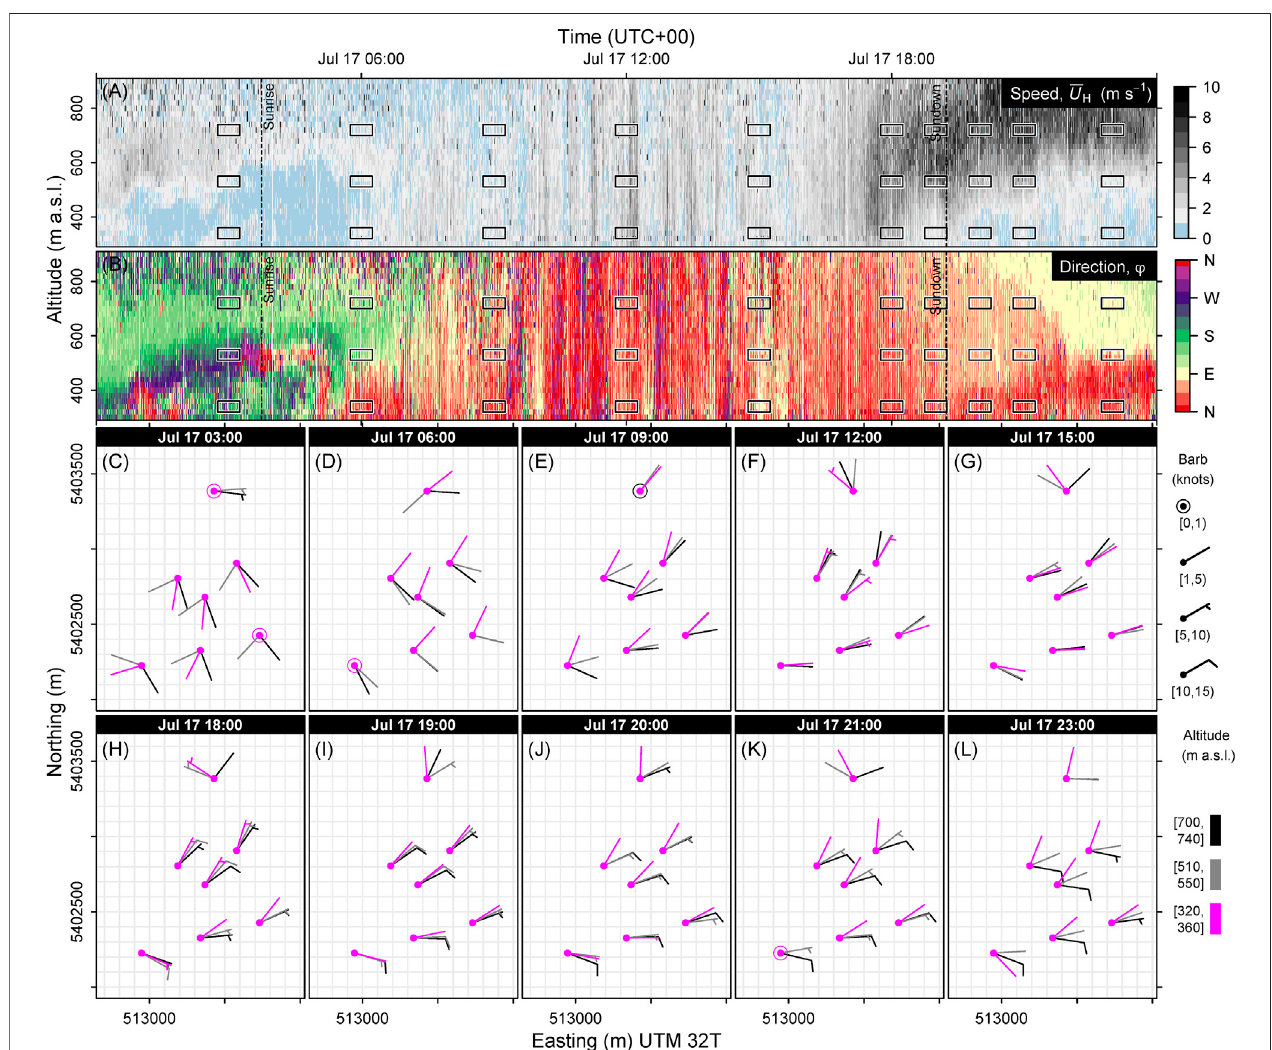
FIGURE8| Foraselectedweak-winddayinsummer(17July2017),acompositeoftheverticalpro fi lesinStuttgartCityCentreof (A) thewinddirectionand (B) the wind speed are shown together with (C – L) the mean wind fi eld for selected locations, altitudes and periods in an area corresponding to Figure 1D . The altitudes and periods are annotated in panels (A,B) by black